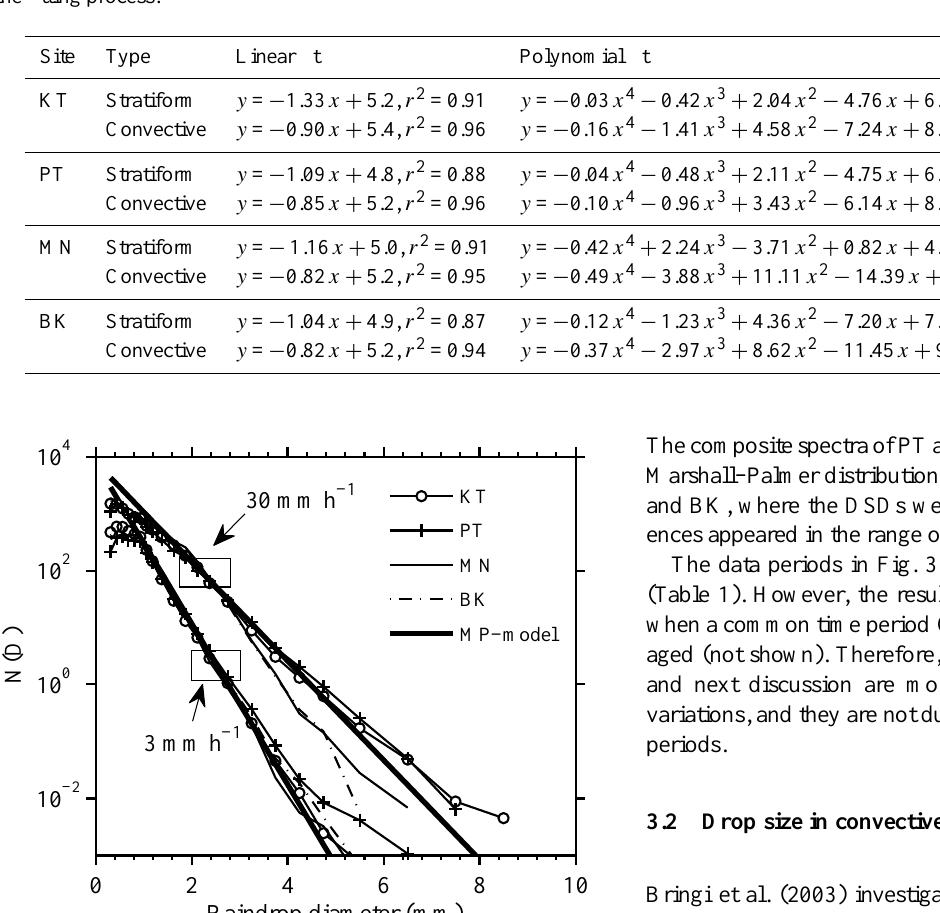
were used as typical values representing light and heavy rain rates ( Kozu et al., 2006). The number of DSD samples at the four sites is more than 700 for light rain and more than 50 for heavy